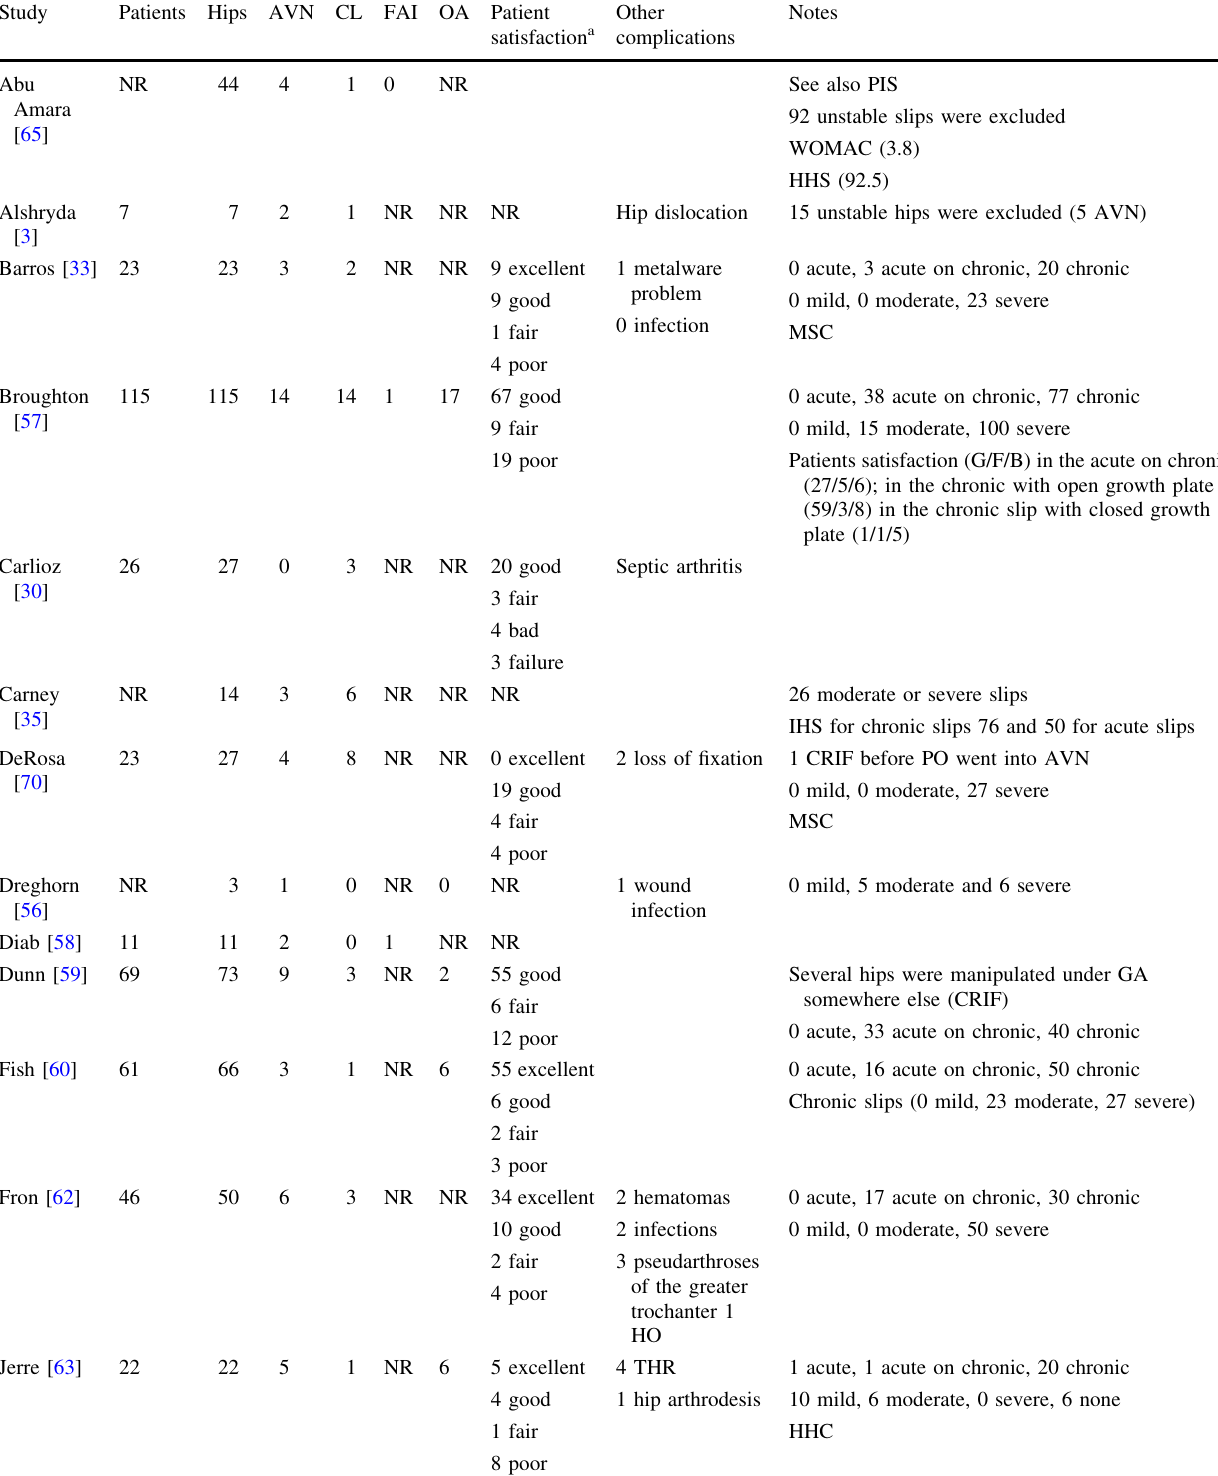
Table 8 Studies of physeal osteotomy in stable slip